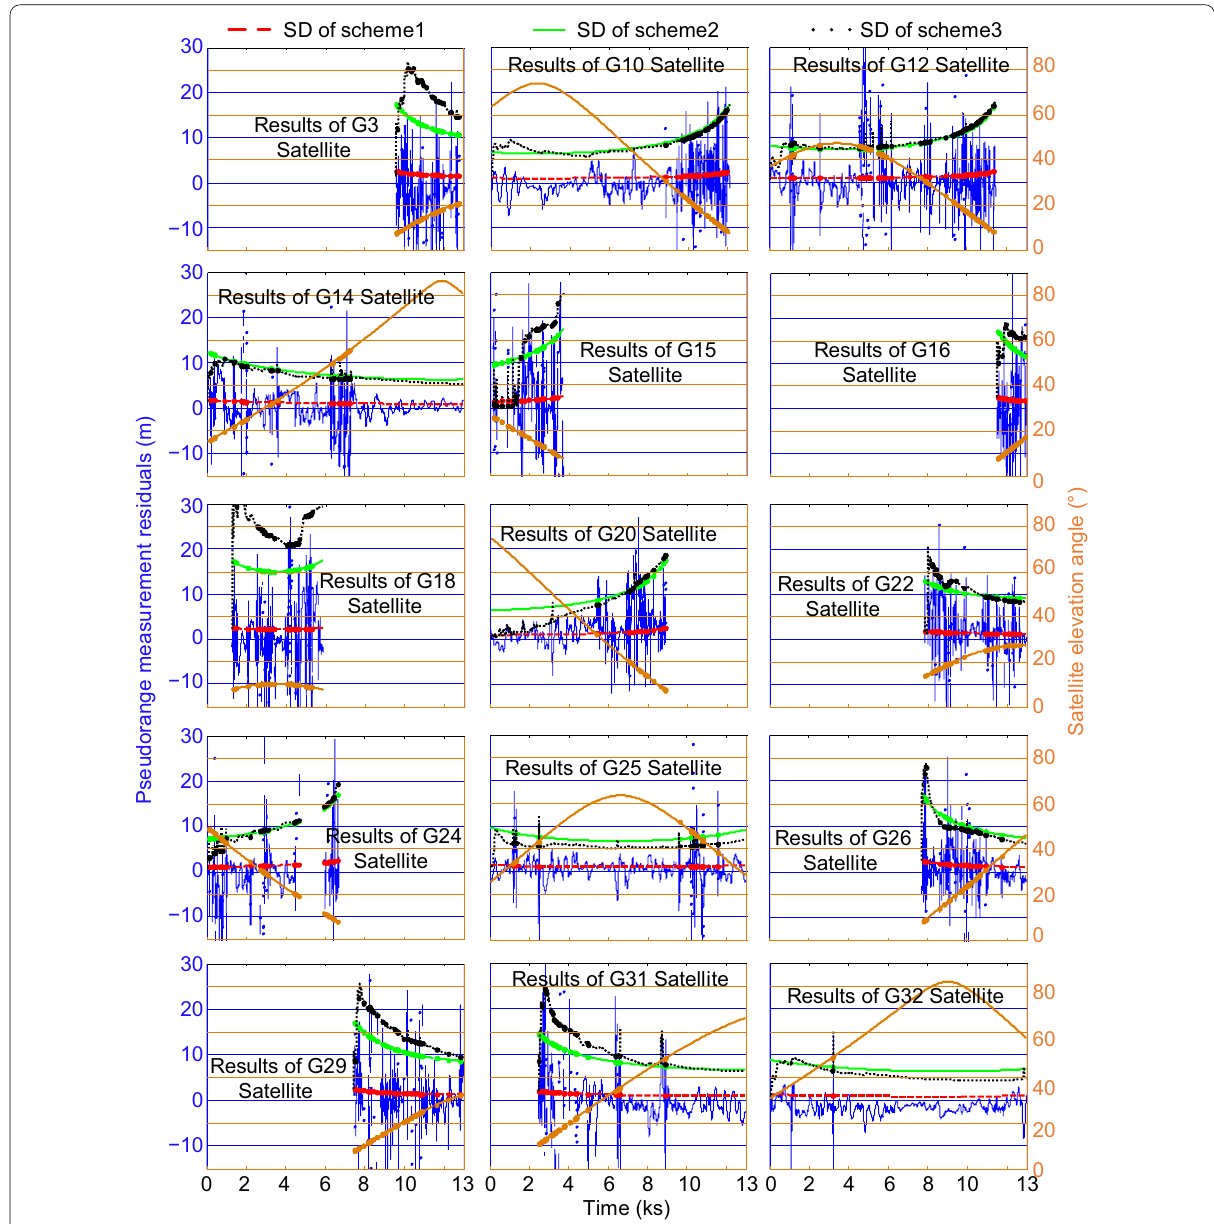
Fig. 13 Pseudorange measurement residuals and standard deviation estimates for each